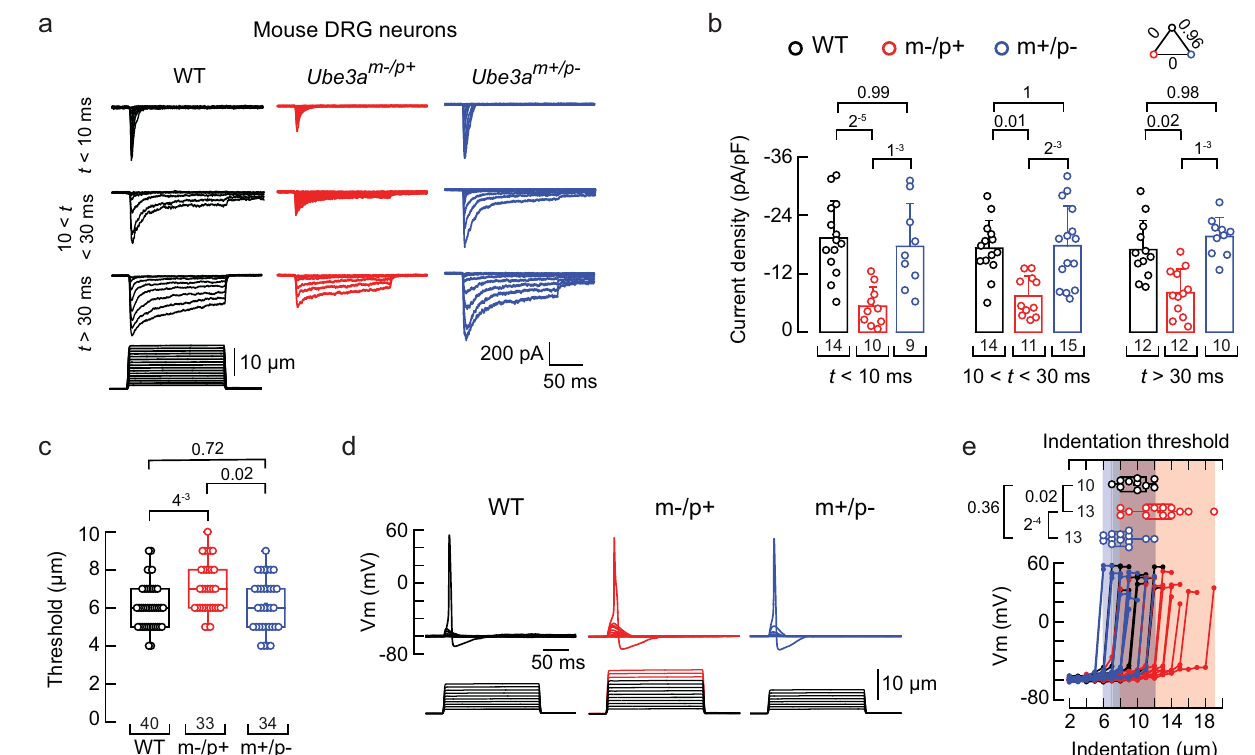
Fig. 1 | Ube3a m – /p+ DRG neurons display reduced mechano-currents and -excit- ability. a Representative whole-cell patch-clamp recording elicited by mechanical stimulation ( − 60 mV) of rapidly, intermediate, and slowly inactivating currents of WT, Ube3a m – /p+ , and Ube3a m+/p – DRG neurons. b Current densities elicited by max- imum displacement of DRG neurons classi fi ed by their time constant of inactiva- tion. Bars are mean±SD. Two-way ANOVA (F=35.44, p =2.63 − 12 ) and Tukey multiple-comparisons test. c Boxplots show the displacement thresholds required to elicit mechanocurrents of DRG neurons. Boxplots show mean (square), median (bisecting line), bounds of box (75 th to 25 th percentiles), outlier range with 1.5 coef fi cient (whiskers), and minimum and maximum data points. Kruskal-Wallis